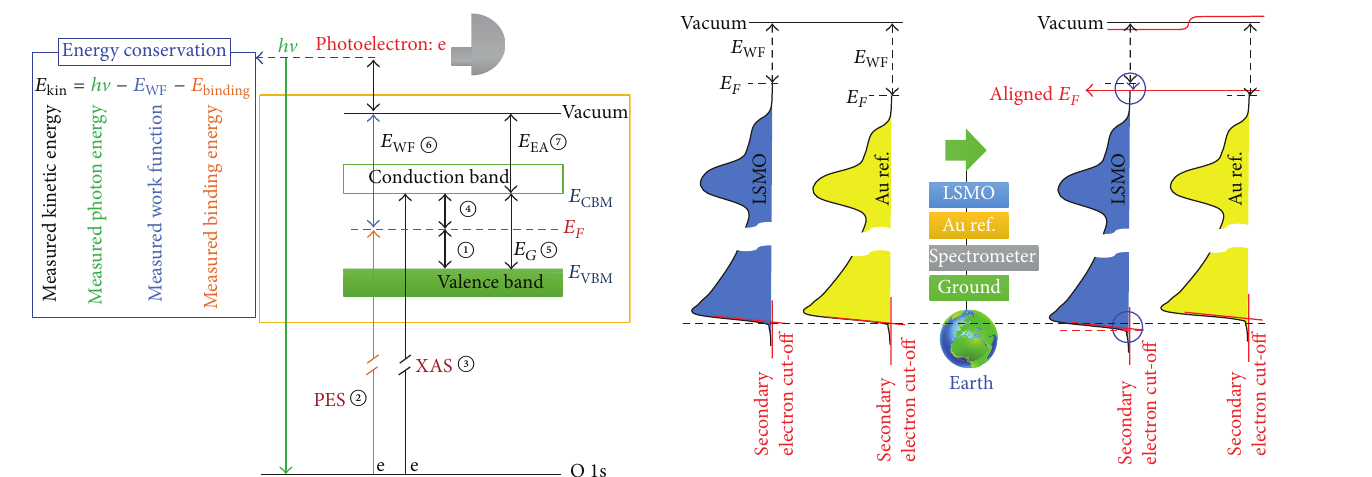
Figure 1: Simplified assembly view of the band diagram and meas- urement principle.